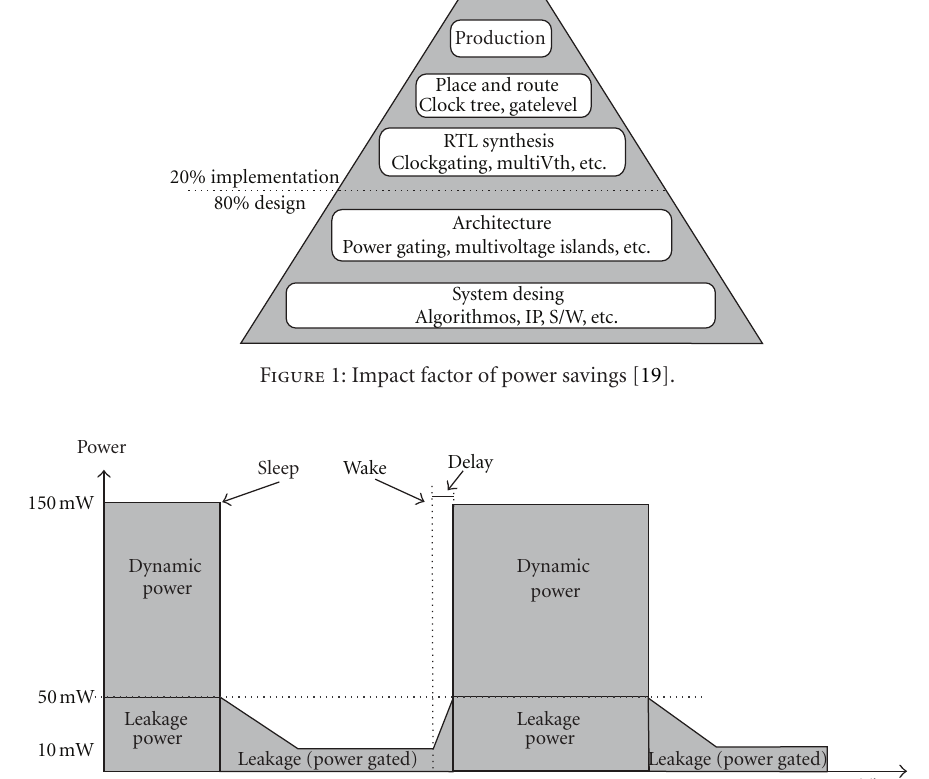
Figure 2: Profile with power gating, adapted